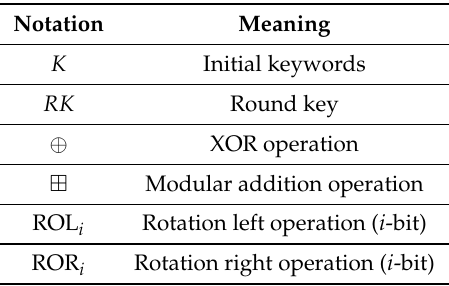
Table 1. Notations.